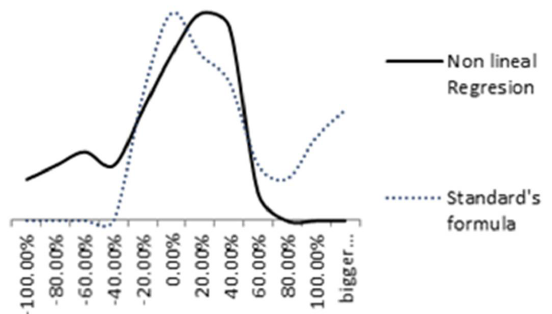
Table 6. Results obtained by Newton’s method for optimised b coefficient.